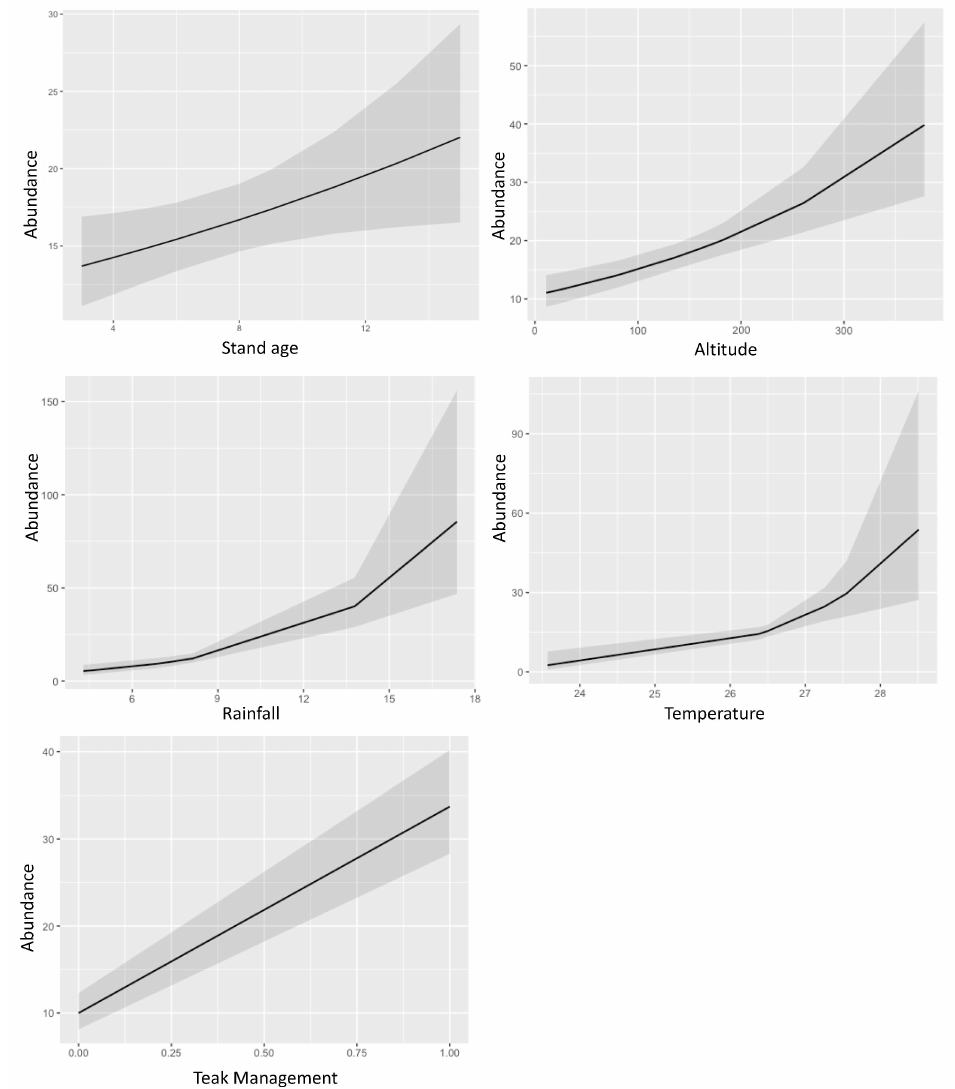
Figure 4. Predicted count of ambrosia beetle abundance on each significant factor: stand age, rainfall, altitude, temperature, and teak